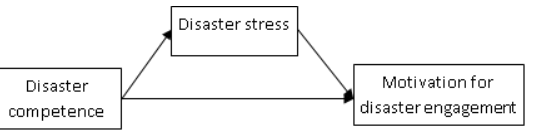
Figure 1. Conceptual model of the relationships between disaster stress, disaster nursing competence, and motivation for disaster engagement.